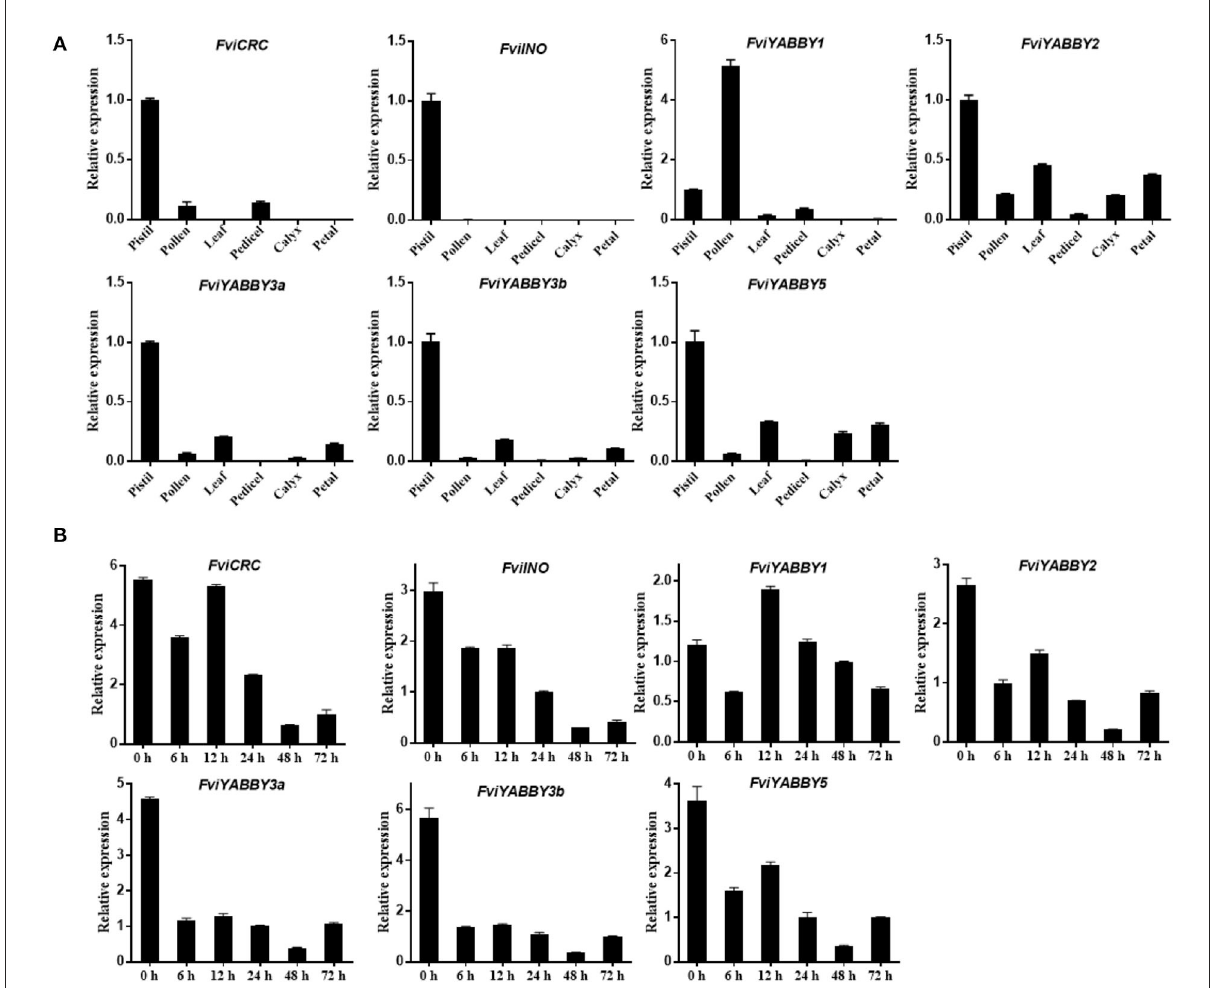
FIGURE6 Analysis of gene expression pattern using RT-qPCR. (A) Tissue-specific expression patterns of YABBY family genes in Fragaria viridis. (B) Spatiotemporal expression after self-pollination of YABBY family genes in F. viridis .